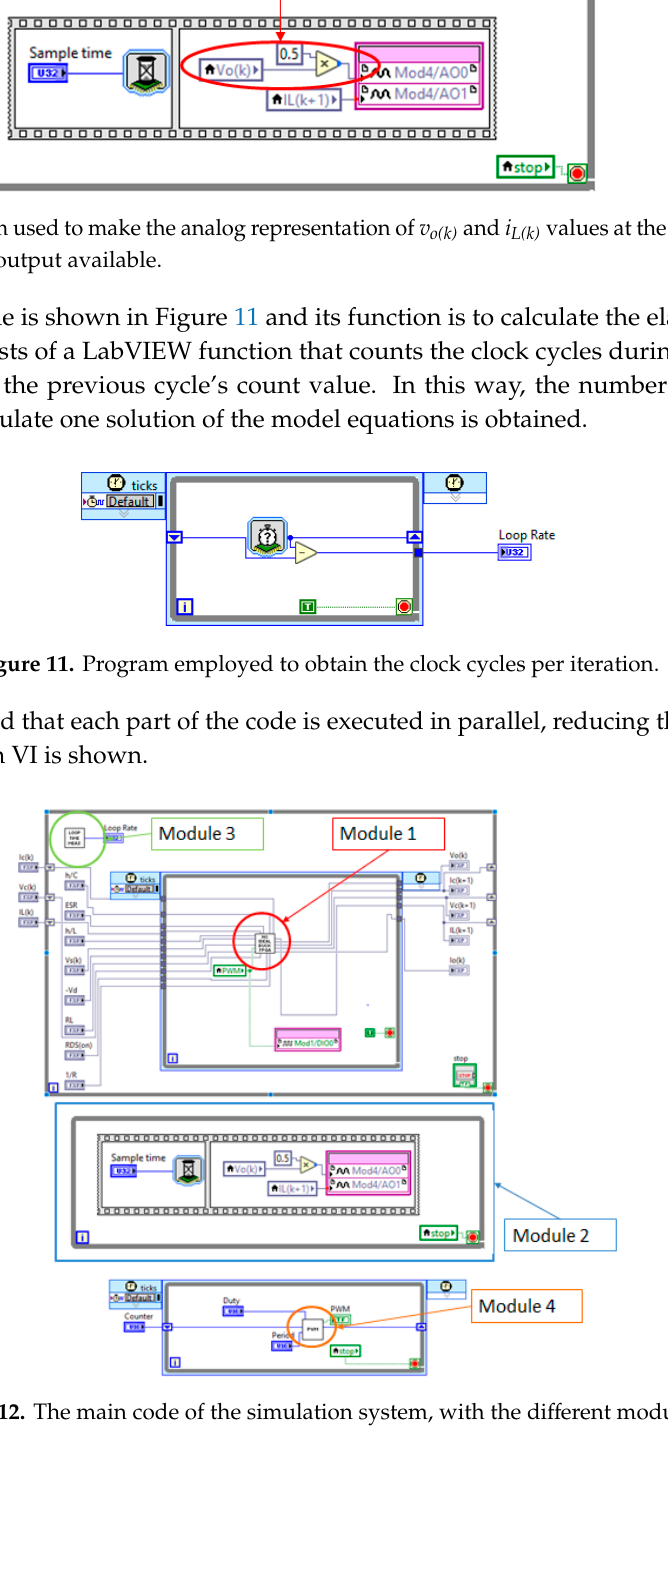
Figure 12. The main code of the simulation system, with the different modules.